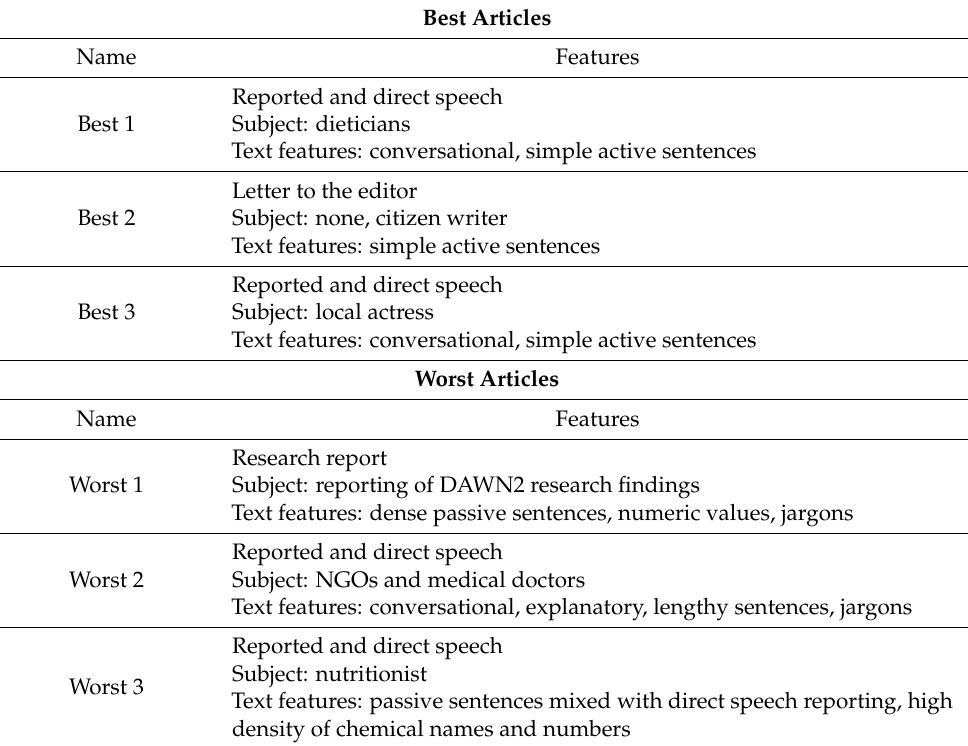
Table 5. Features of the three best and three worst scoring